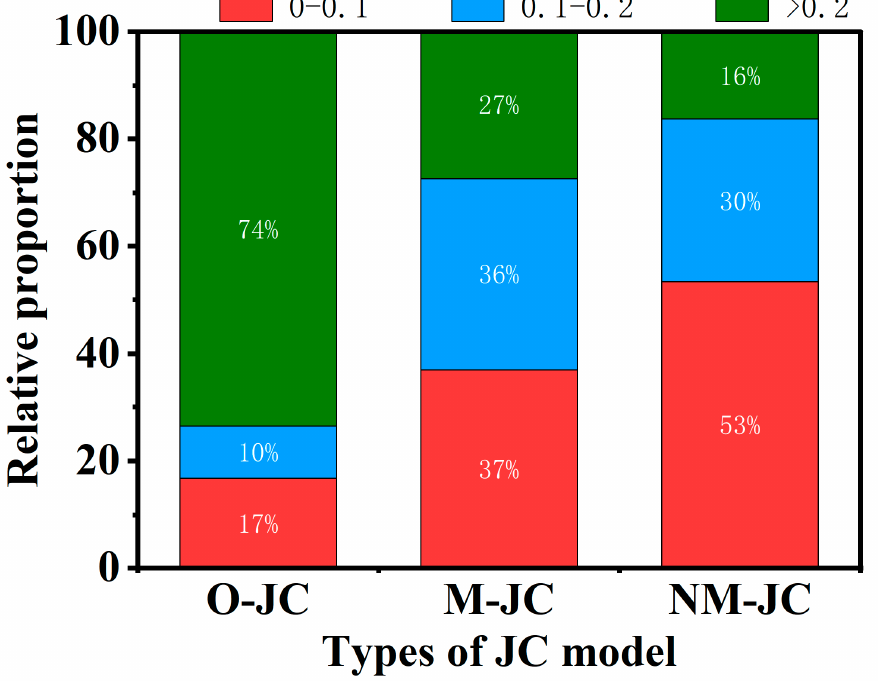
Figure 12. The relative proportion of the range of RE values.